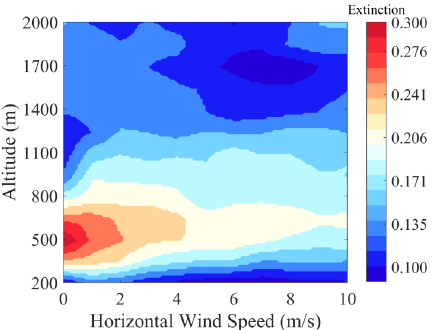
Figure 16. Average extinction coefficient at different wind speeds and altitude from fixed-location observations of a total of 89d at Haizhu Lake Research